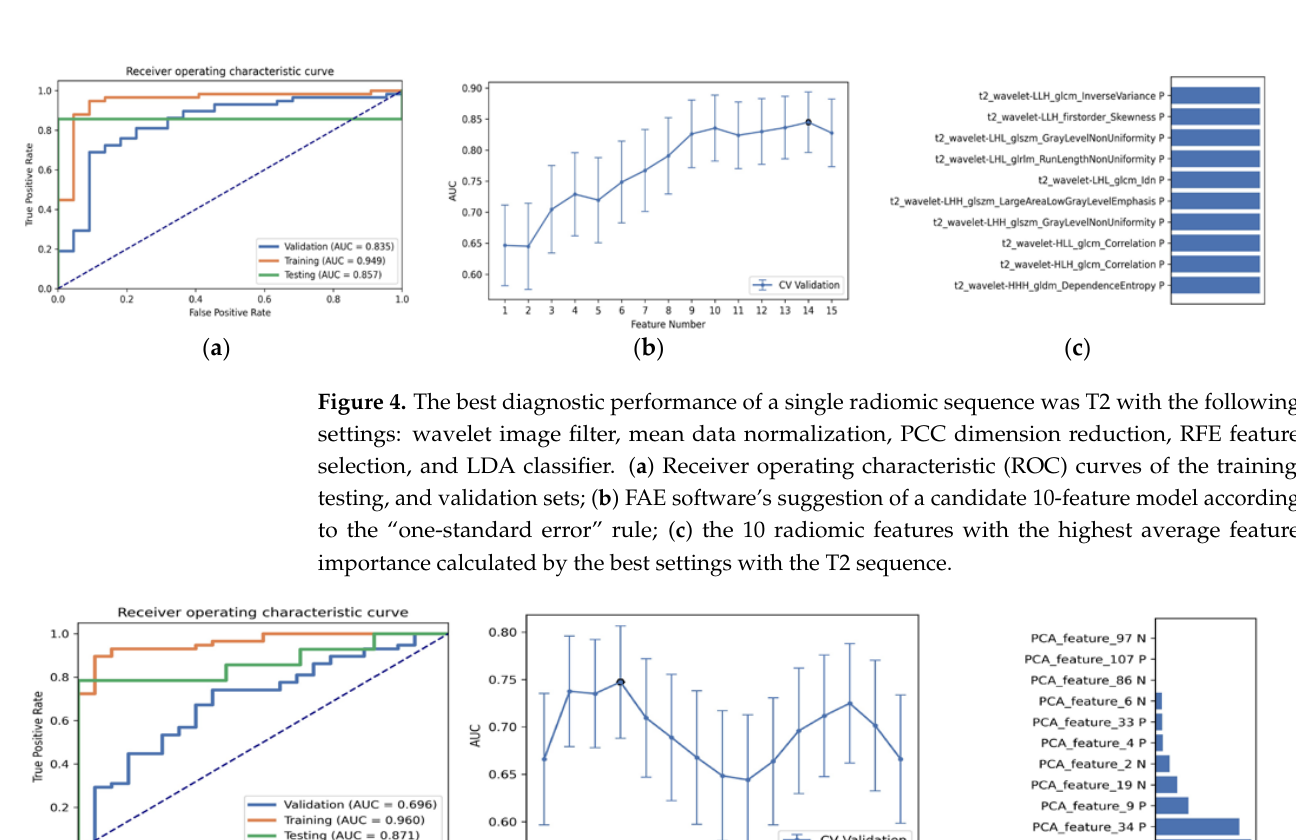
the 14 radiomic features with the highest average feature importance calculated by the best settings